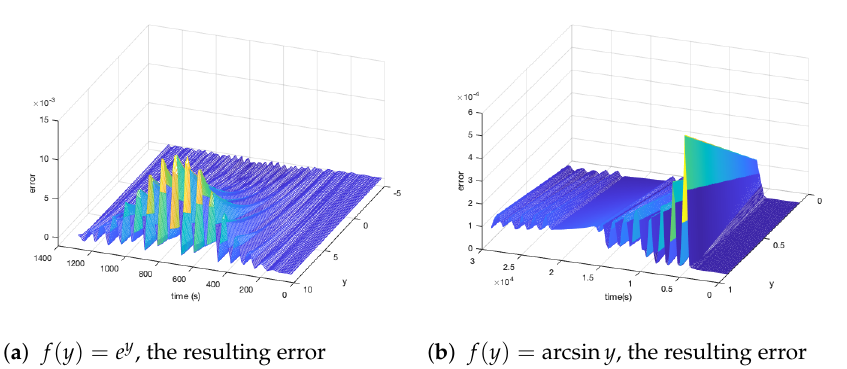
Figure 7. Errors ( a ) and ( b ) generated by simulation algorithms over time and value growth. The y-axis represents the value of y, the x-axis represents the simulation time length, and the z-axis represents the error between the x calculated in the CRNs and the actual